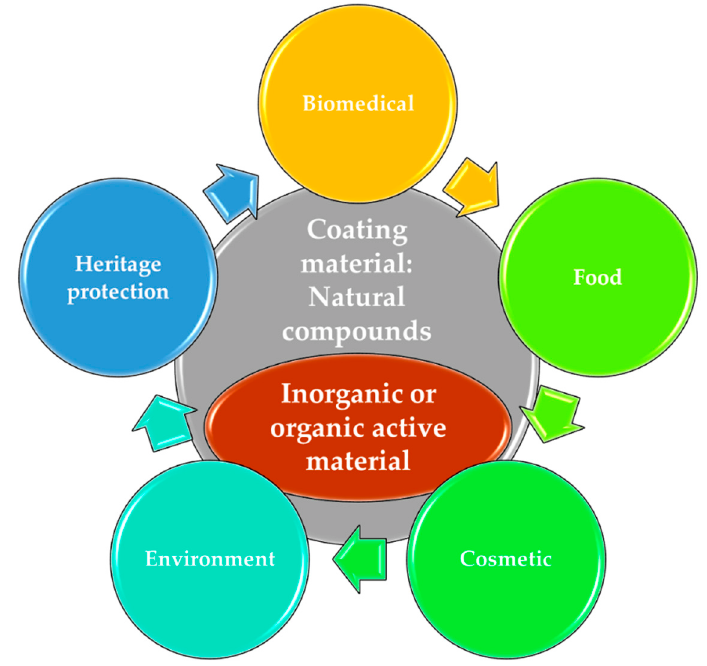
Figure 1. Schematic representation of the manuscript content.